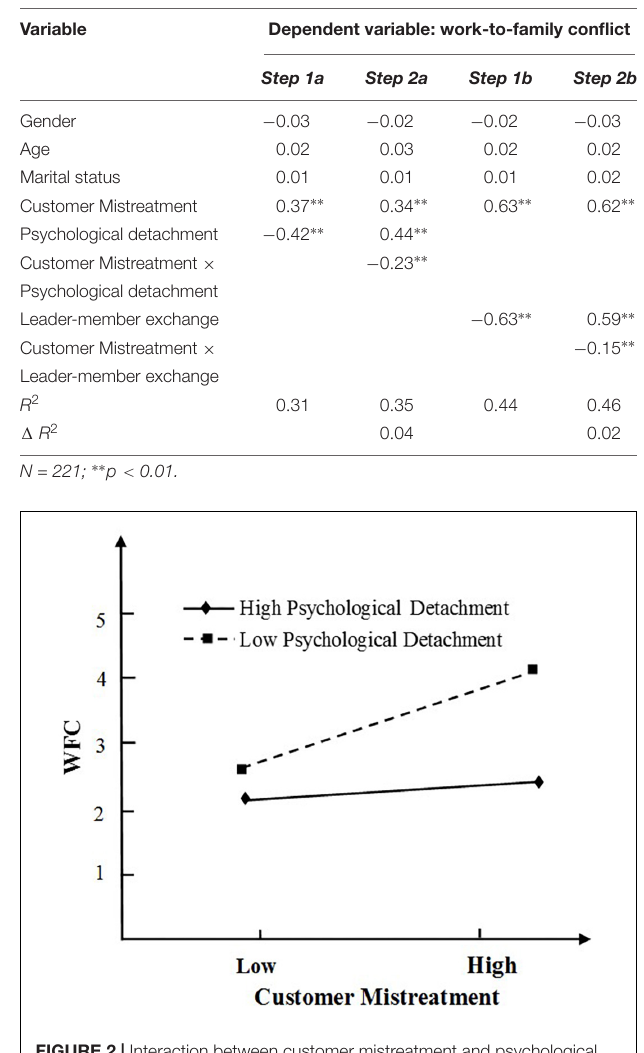
indirect effects of customer mistreatment on family